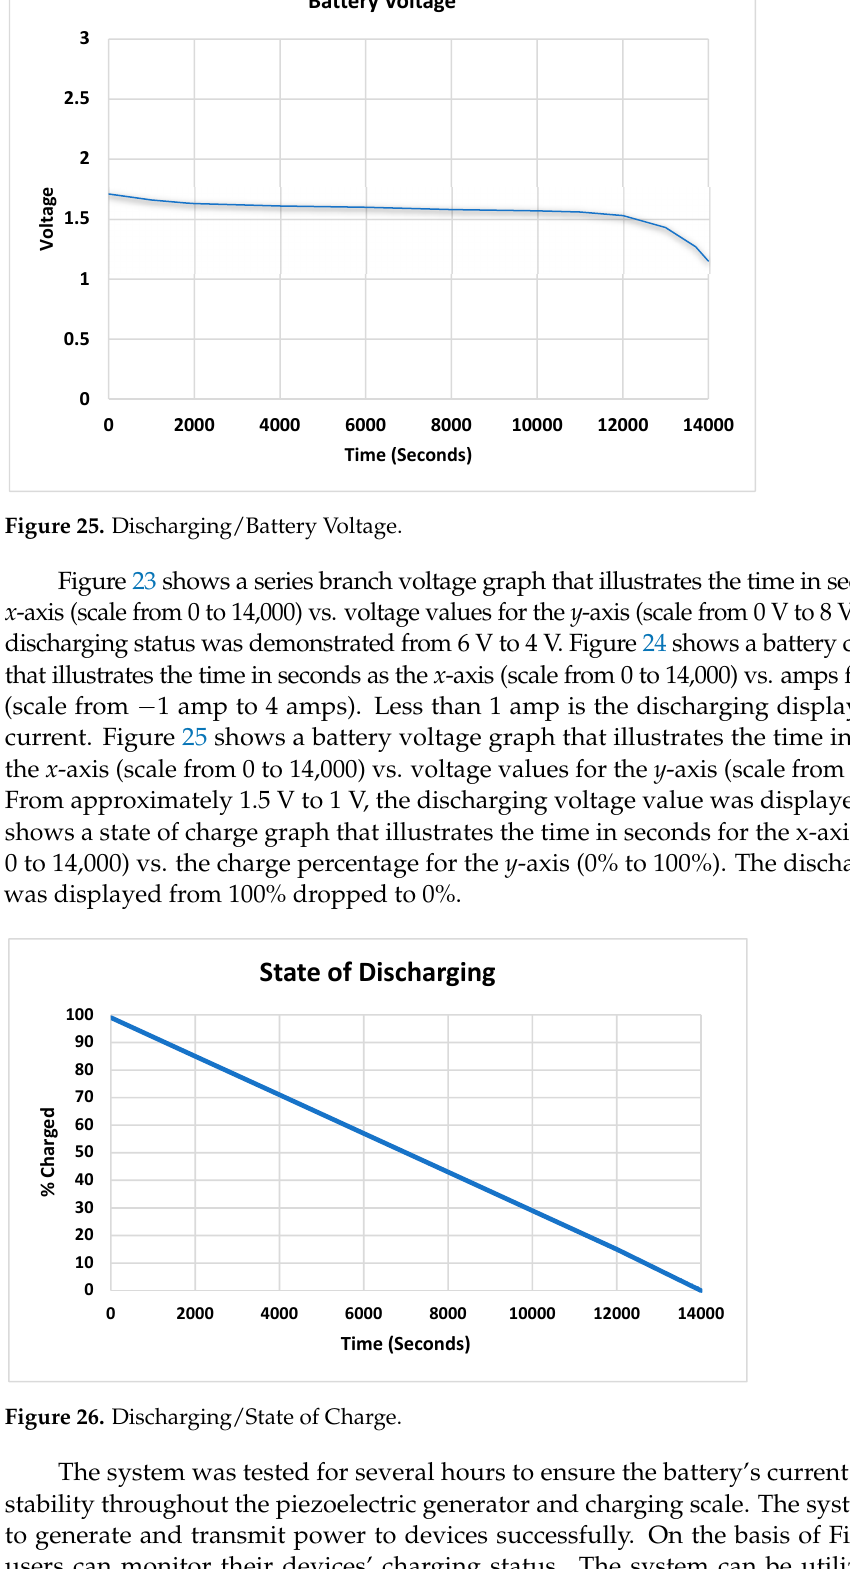
Figure 24. Discharging/Battery Current.